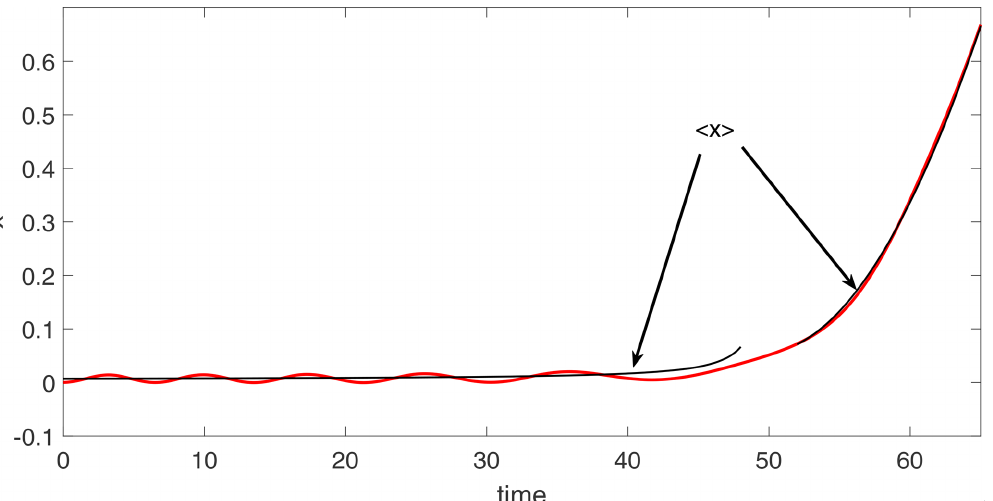
Figure 4. Numerical solutions of x(t) in Eqs. (2)–(5) starting from the same initial conditions as in Fig. 3. The two black curves show the monotonic evolution of x described by Eq. (20) for t < t cr and by Eq. (21) for t > t cr , where t cr = 50 as in Fig. 3. The black curves terminate near the Equator where the adiabaticity breaks down since the frequency, ω 0 , tends to 0 there according to Eq. (15).